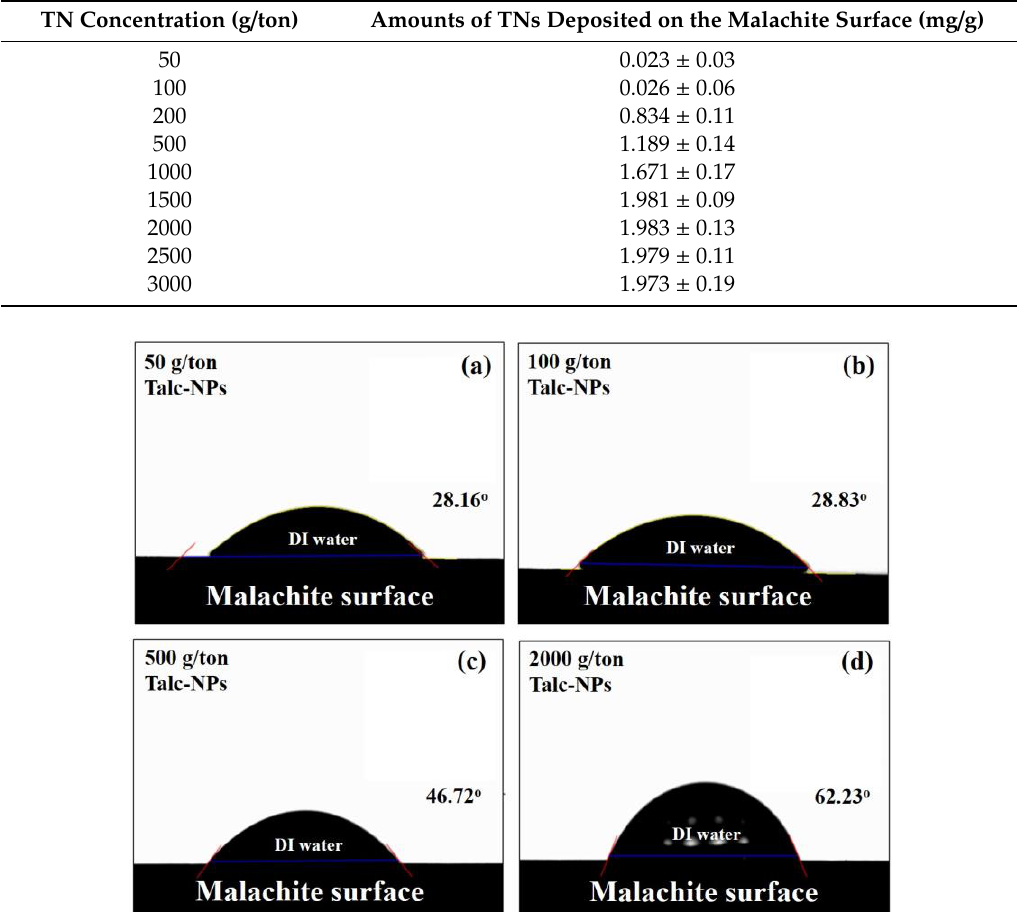
Figure 9. Contact angles for malachite after TN deposition at 50 ( a ), 100 ( b ), 500 ( c ), and 2000 ( d ) g/ton at pH 6, respectively.